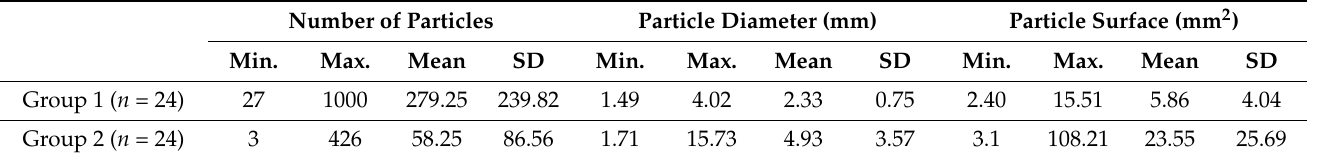
Table 2. Masticatory efficiency—particle number and